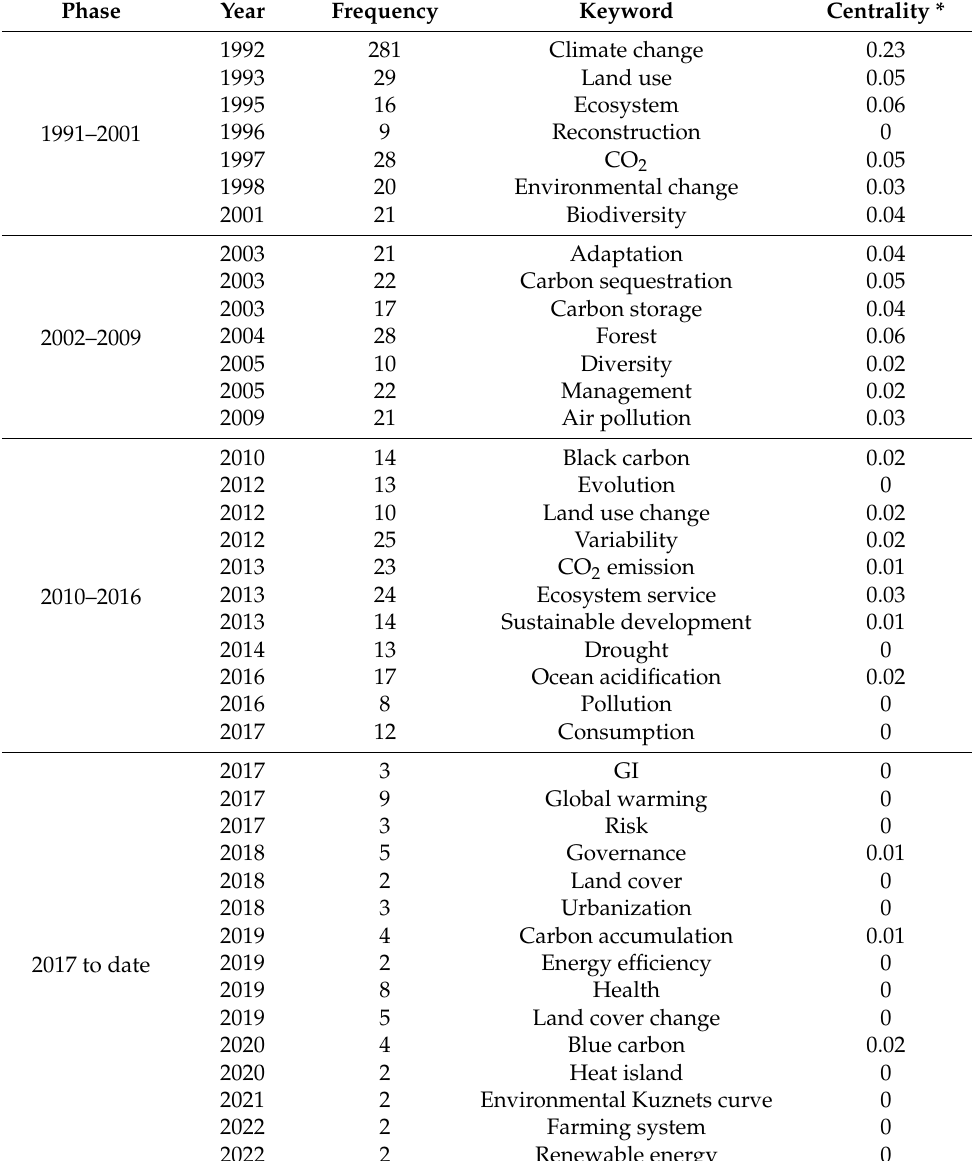
Table 2. Centrality and frequency of RCHSCC high-frequency keywords. Phase